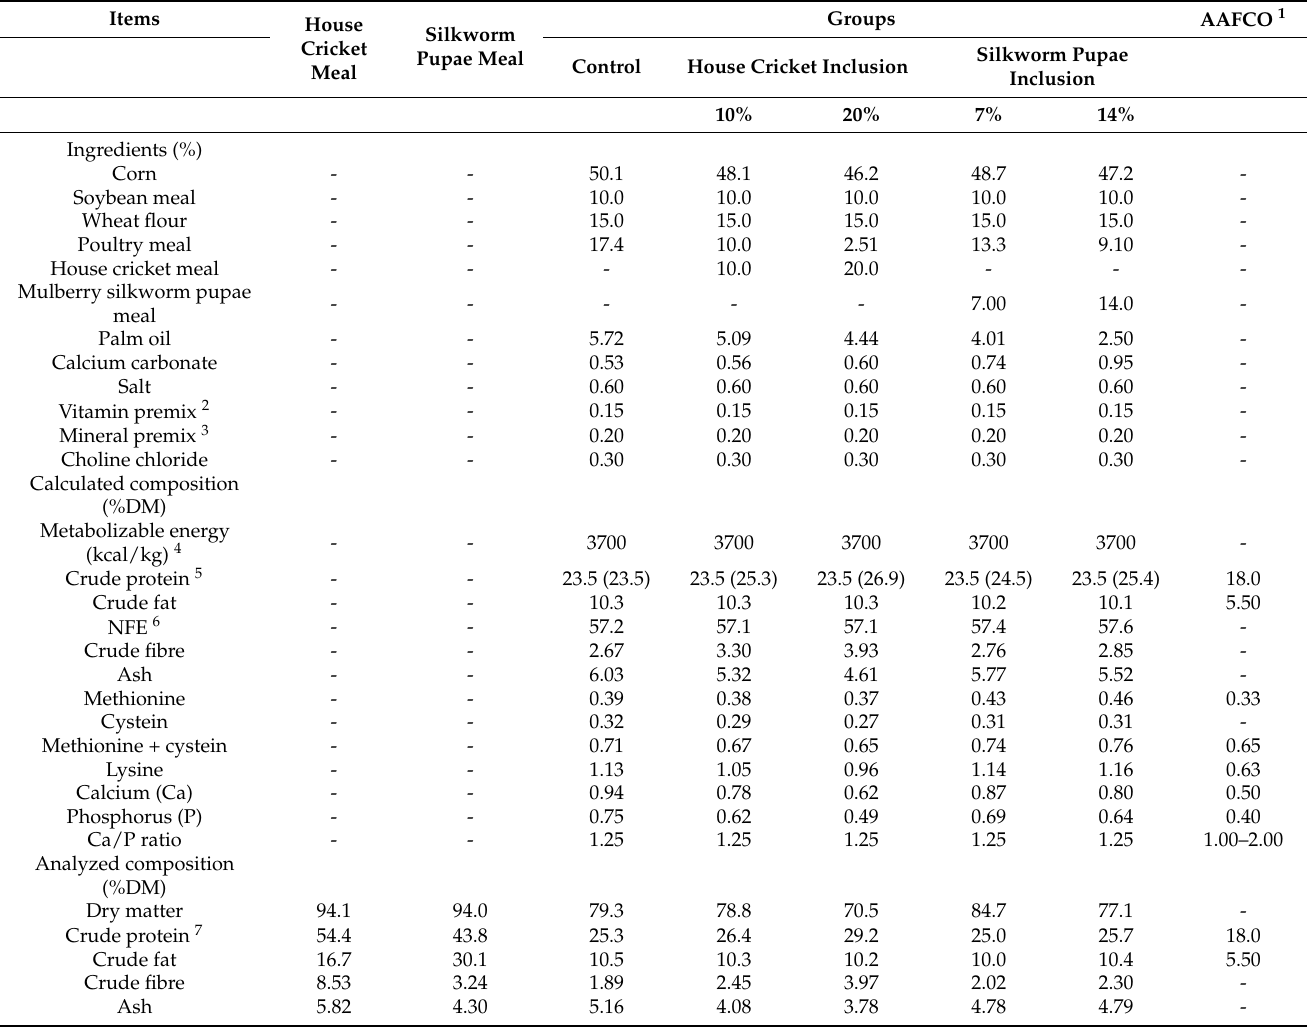
Table 1. Ingredients and chemical compositions of the experimental